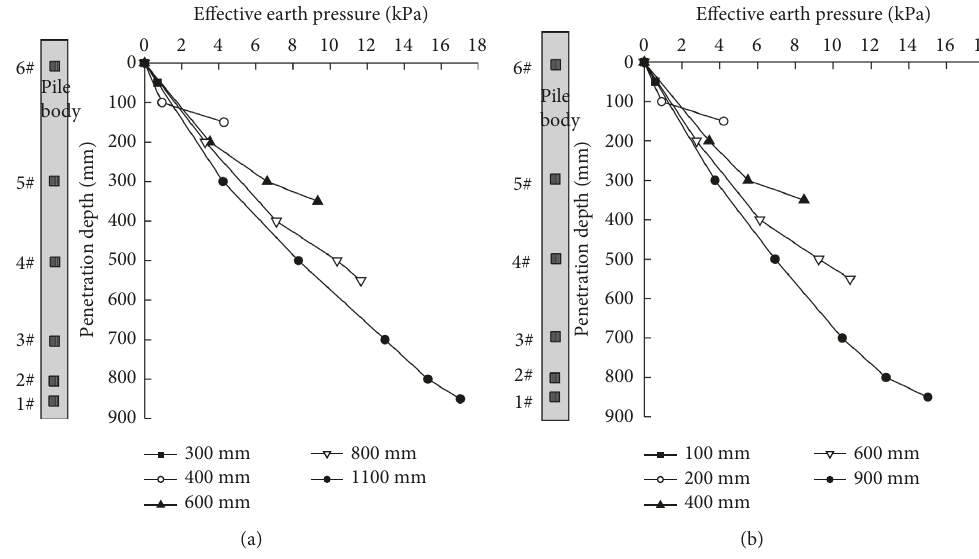
Figure 6: Distribution of effective earth pressure on test piles TP1 and TP2 during pile jacking: (a) TP1, (b) TP2.